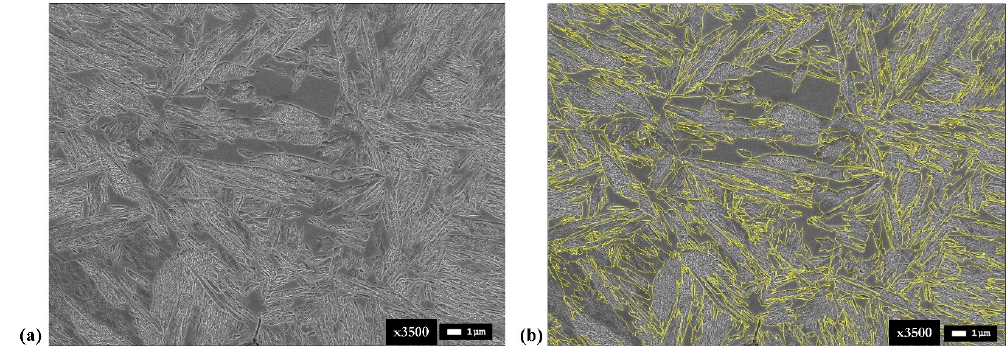
Figure 7. SEM images of a Q&P sample (QT = 230 °C PT/t = 400 °C/0 s). ( a ) The carbon-rich martensite/austenite (MA) islands appear unetched and the carbon depleted phases appear etched, ( b ) delineation of the MA island features on the SEM image of the Q&P sample (QT = 230 °C PT/t = 400 °C/0 s).